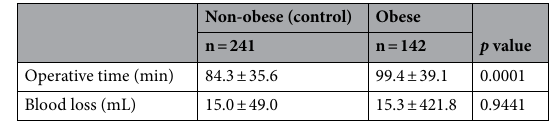
Table 5. Operative factors.